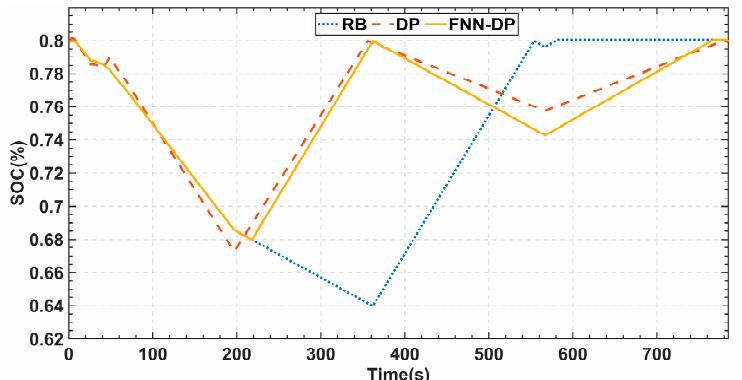
Figure 18. Comparison of fuel consumption between RB strategy, DP strategy and FNN-DP